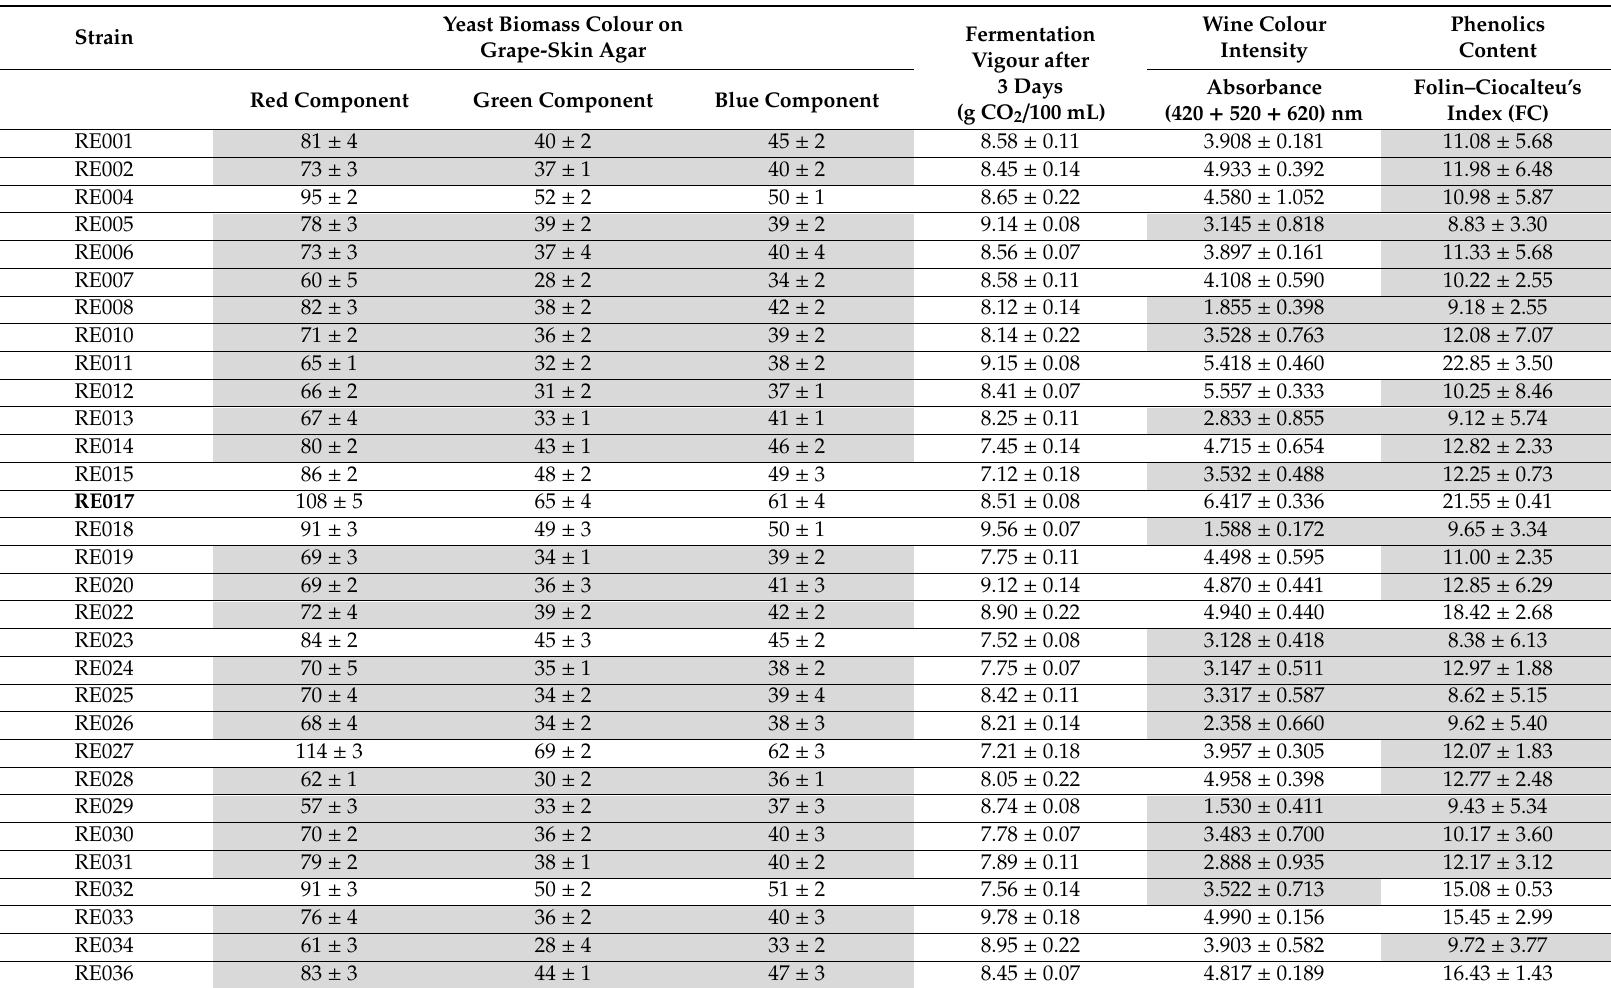
Table 2. Fermentation vigour and assessment of pigments and phenolics adsorption activity showed by the 85 preselected S. cerevisiae